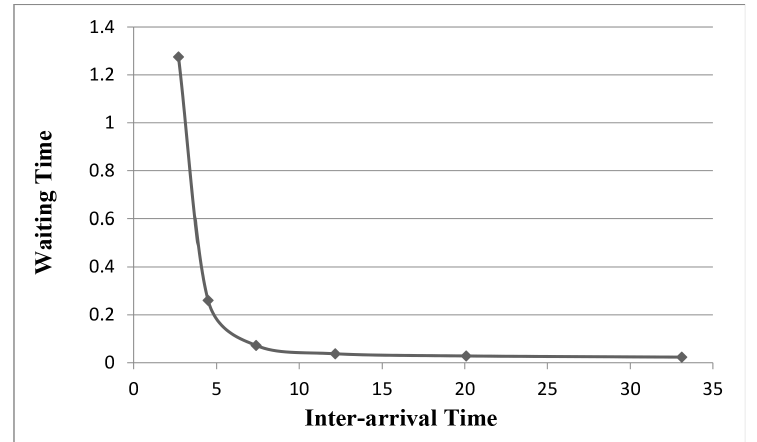
Figure 2. The impact of request arrival on waiting